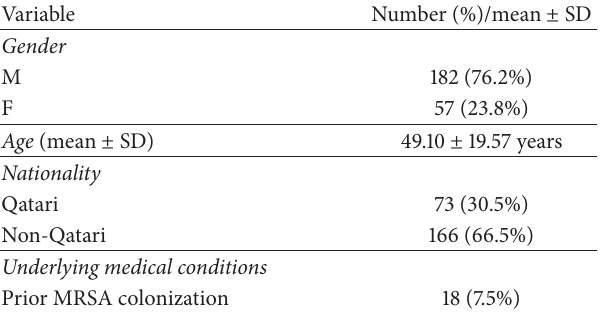
Table 1: Demographic and clinical data of the 239 patients involved in this study.